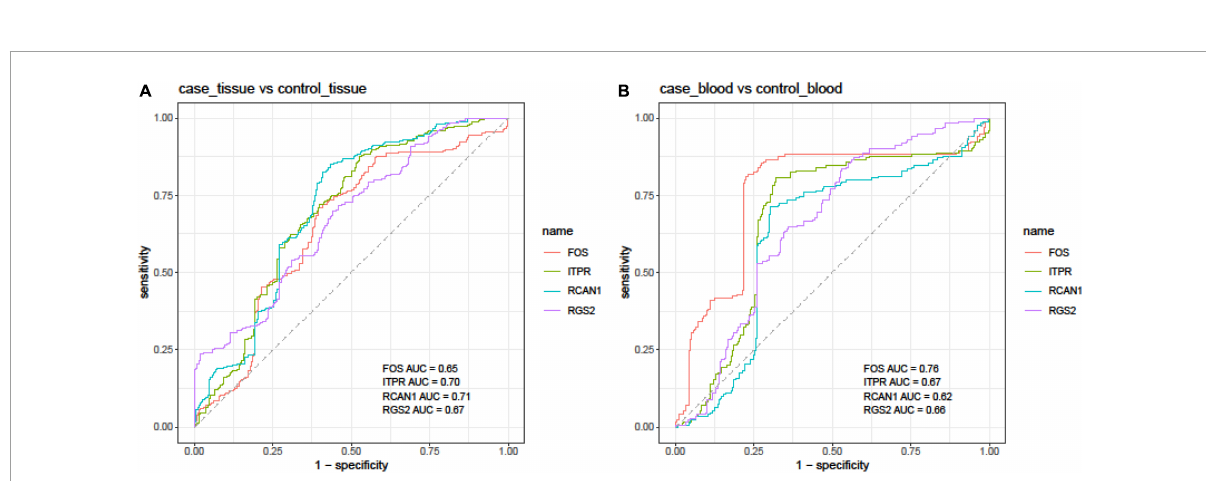
FIGURE4 Receiver operating characteristic (ROC) curves depicted using the Bayesian generalized linear